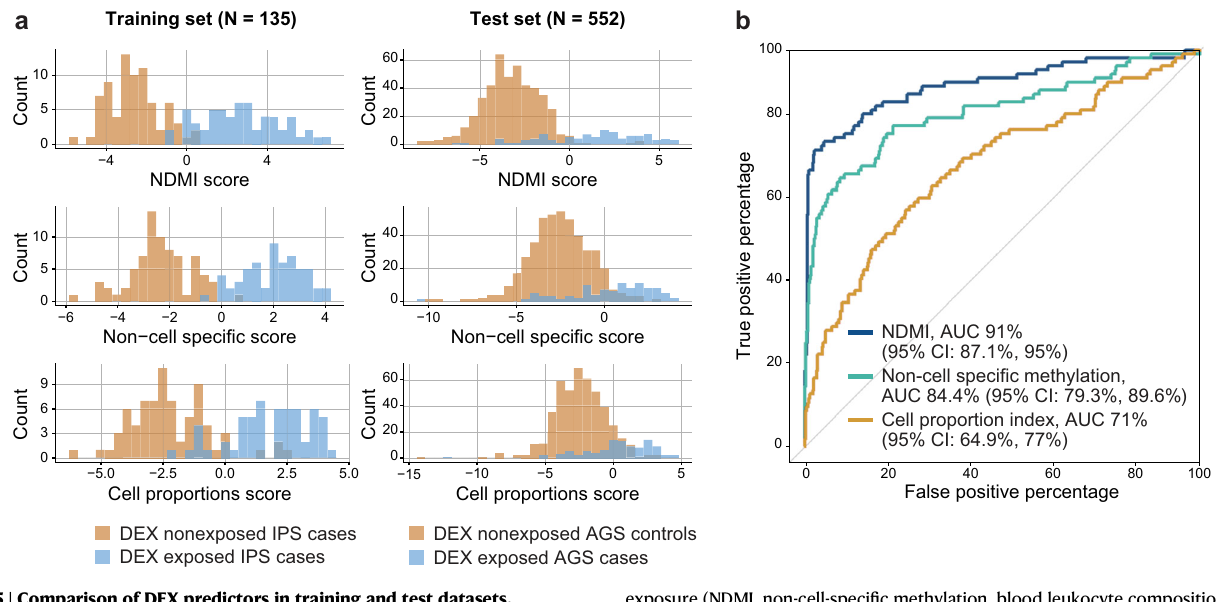
exposure (NDMI, non-cell-speci fi c methylation, blood leukocyte composition). Source data are provided as a Source Data fi le.